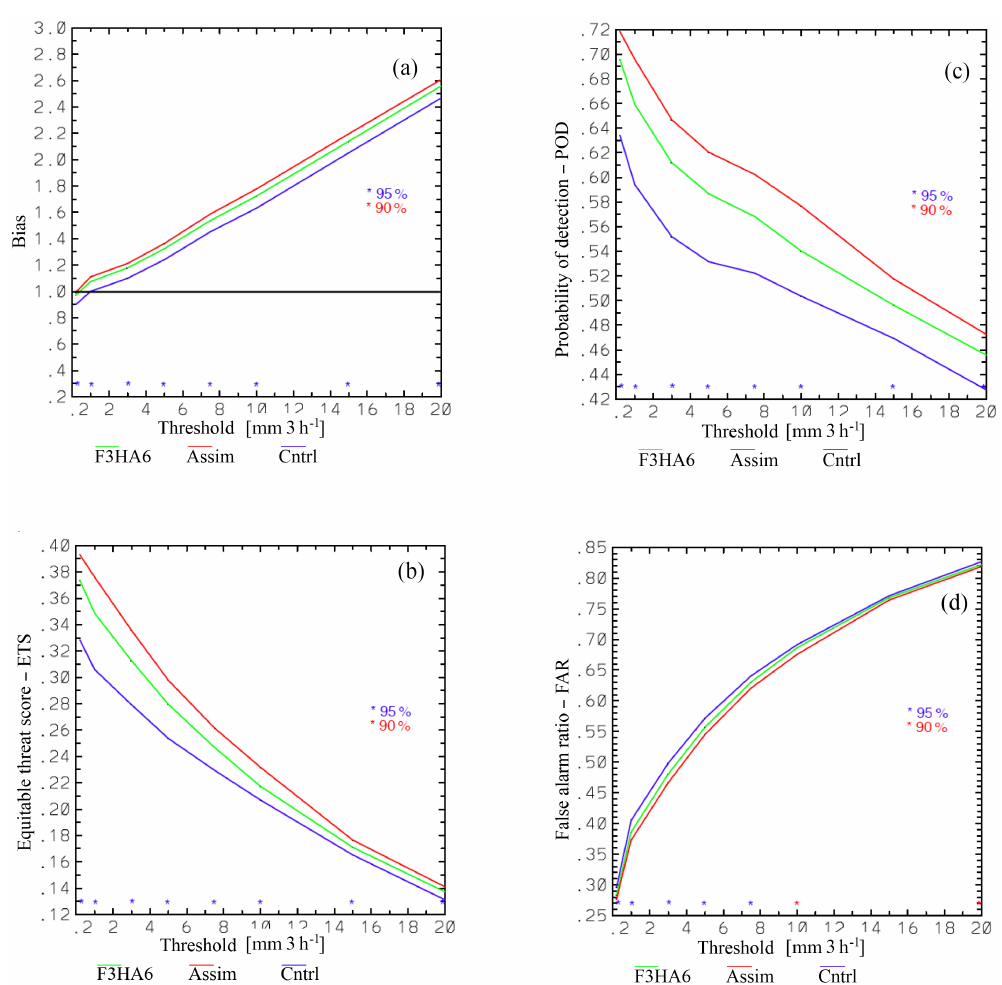
Figure 9. Scores for the 3h precipitation computed by summing the 160 contingency tables of the 20 case studies: (a) bias (the line of the perfect score 1.0 is shown in black); (b) equitable threat score; (c) probability of detection; (d) false alarm ratio. F3HA6 is in green, ASSIM is in red, and CNTRL in blue. The asterisks above the x axis show the results of the hypothesis testing (95% blue, 90% red) of the difference between F3HA6 and CNTRL